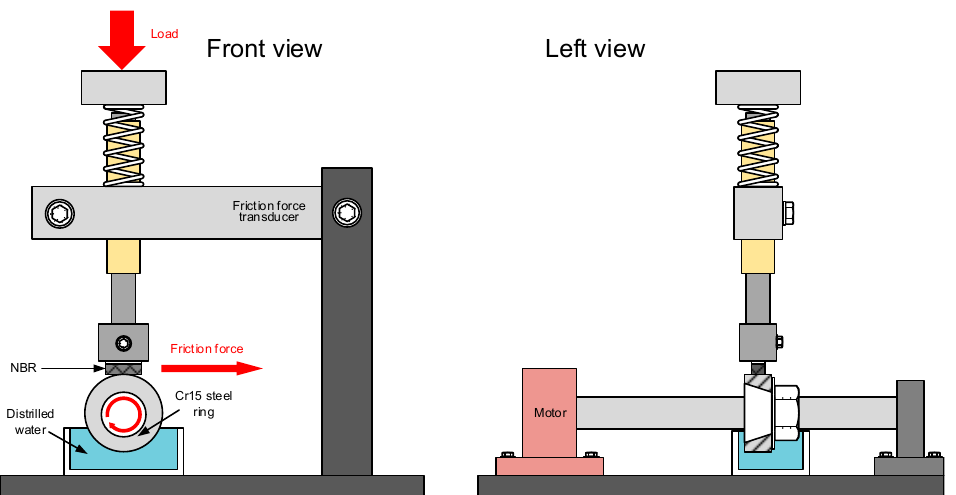
Figure 1. Schematic image of block-on-ring tribometer.